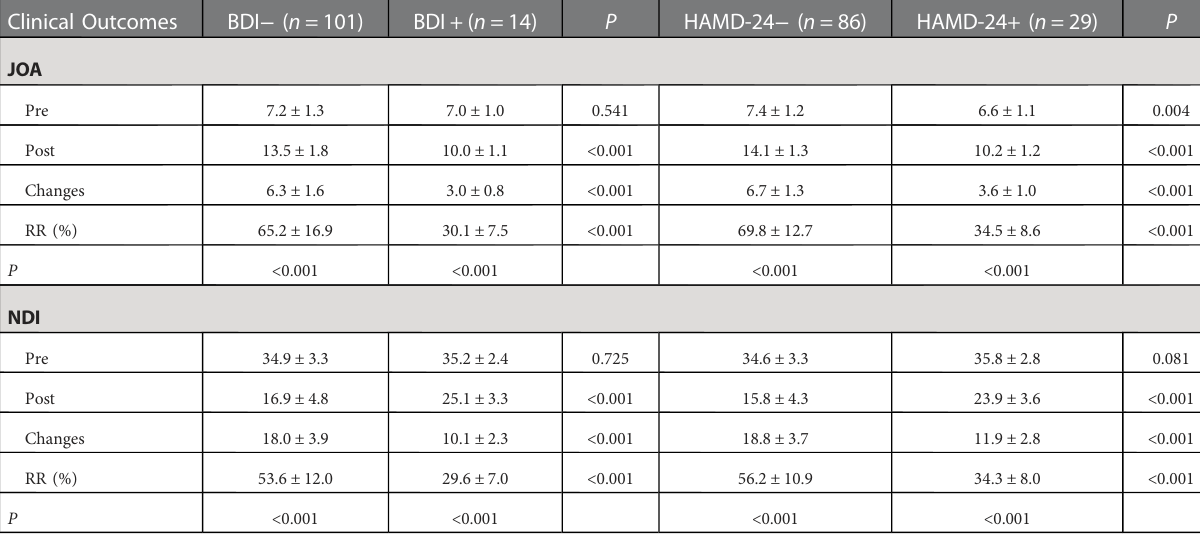
TABLE 2 Postoperative outcomes and improvement comparison in BDI and HAMD-24